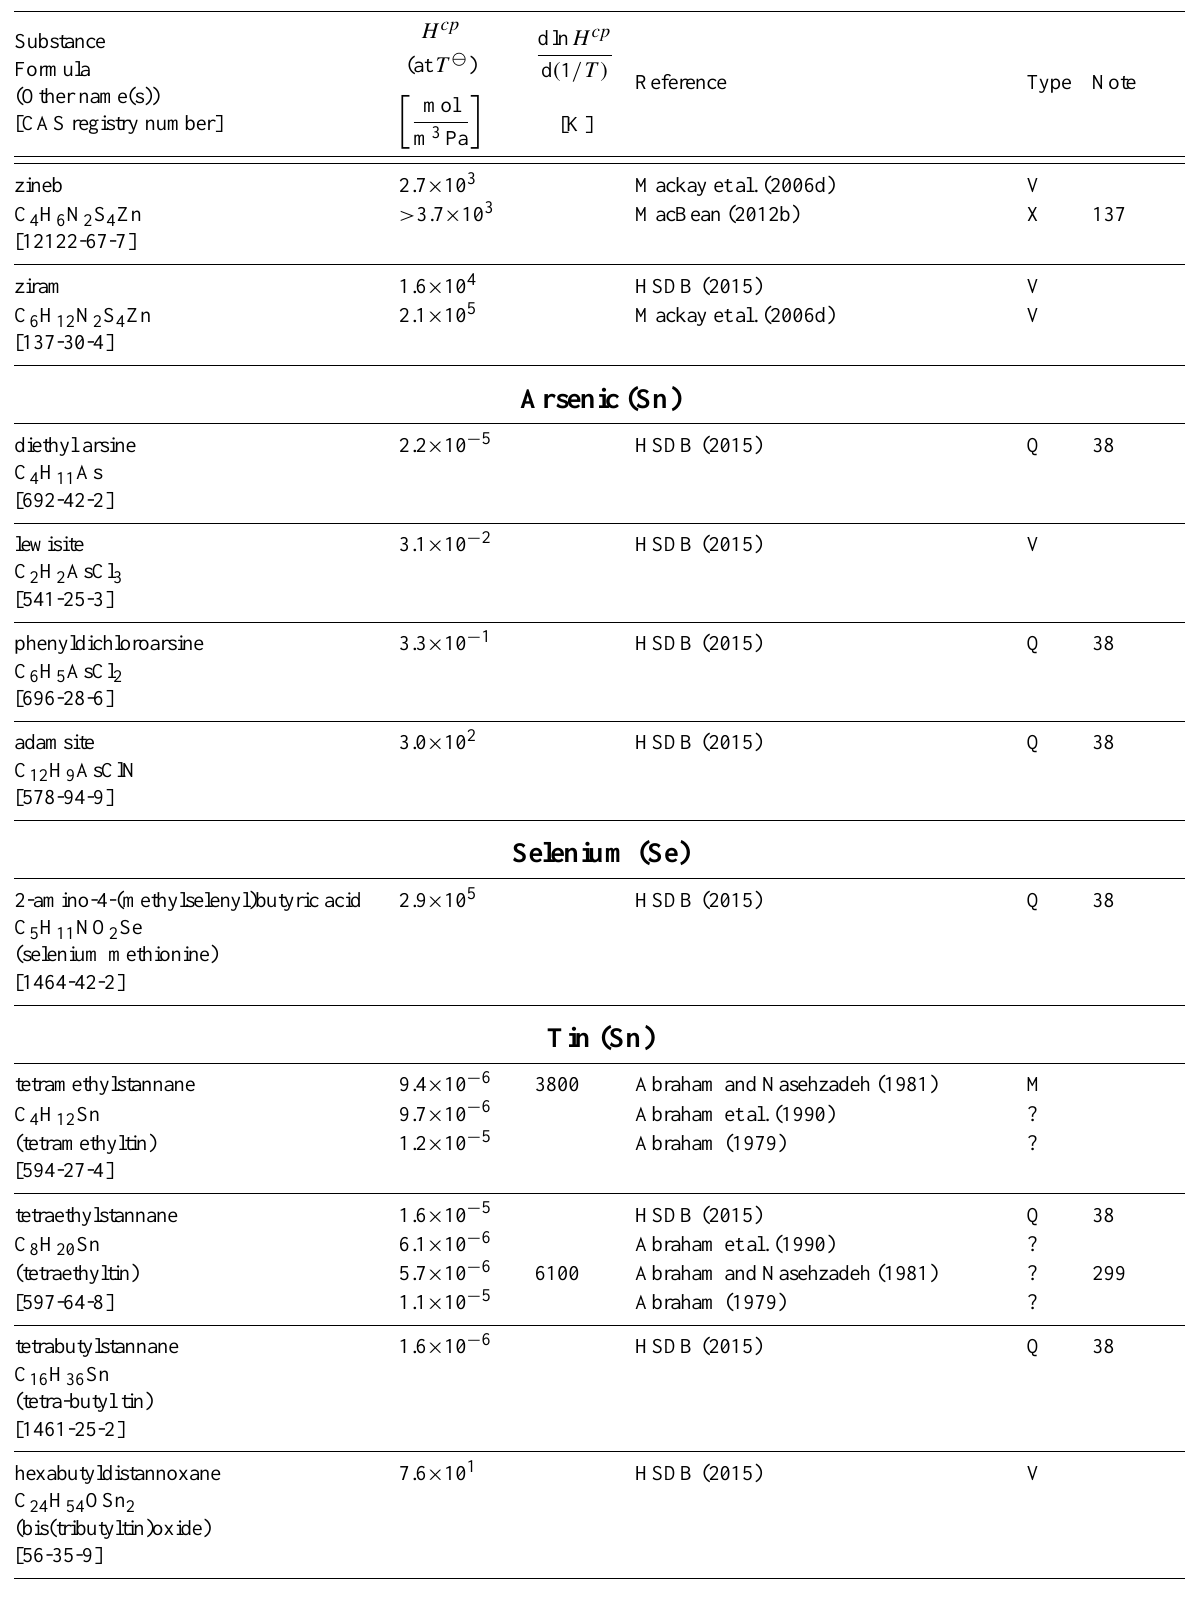
Table 6: Henry’s law constants for water as solvent